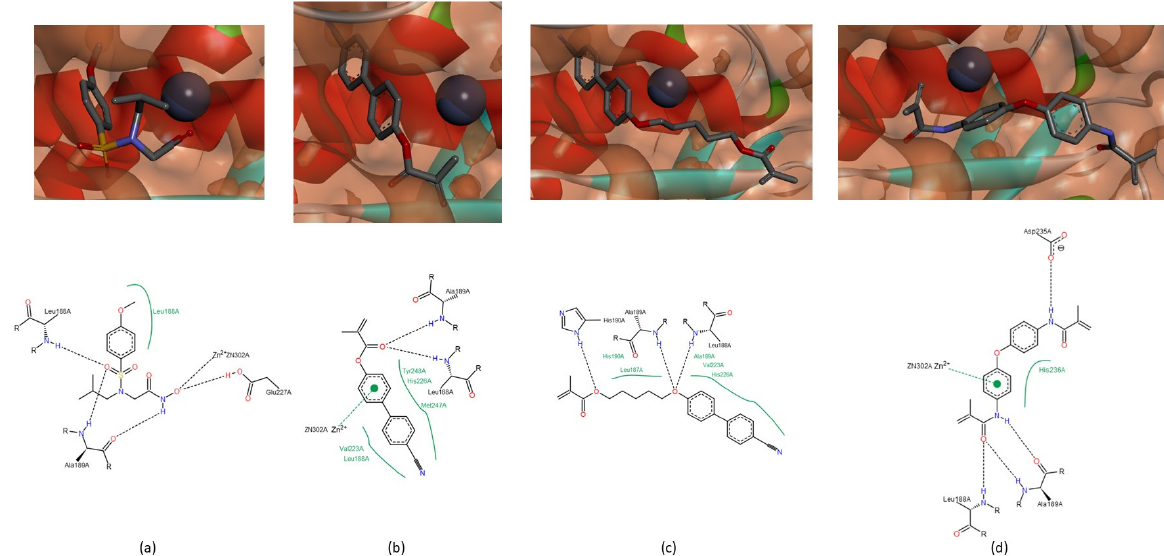
Figure 6. Interactions between the NNGH inhibitor and the compounds A, B and C and the MMP-9. ( a ) NNGH inhibitor. Leu 188 and Ala 189 interact with the oxygen atom of the sulfonyl group and the NH group of hydroxamic acid. ( b ) Compound A. Leu 188 and Ala 189 establish a hydrogen bond with the oxygen atom of the carbonyl group, simultaneously. ( c ) Compound B. Interactions between Leu 188 , Ala 189 and His 190 and the oxygen atom of methacrylate and adjacent to the biphenyl group, respectively. ( d ) Compound C. The methylacrylamide can establish a hydrogen bond with Leu 188 , Ala 189 and the residue Asp 235 .